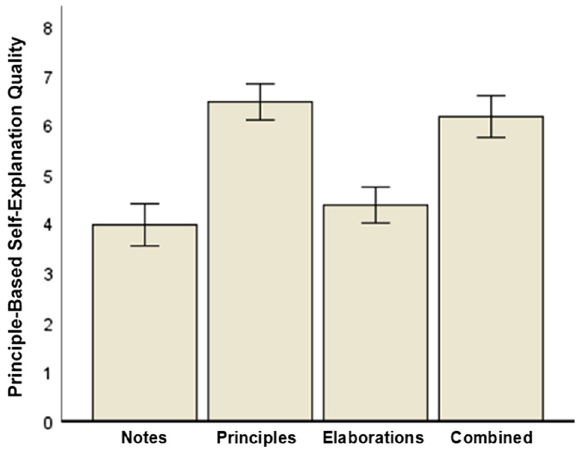
Fig. 1 Principle-based self-explanation quality with respect to prompt type. Error bars: 95% CI